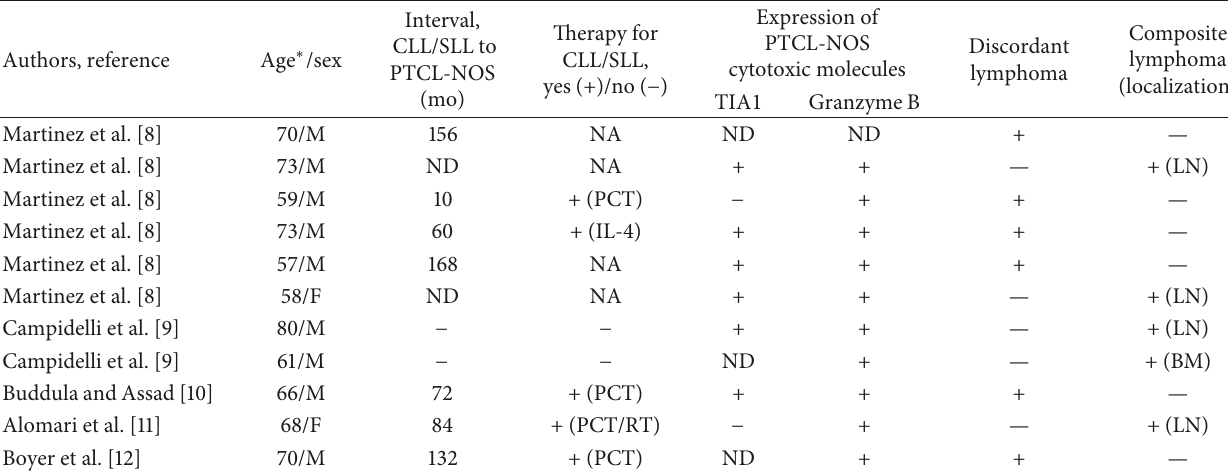
Table 1: Review of the literature for PTCL-NOS in CLL/SLL